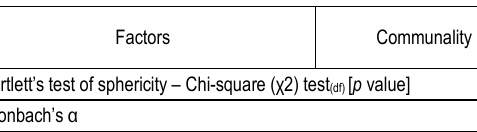
Table 8. Factor analysis (grade of the agreement or disagreement for financial institutions, NGOs and religious